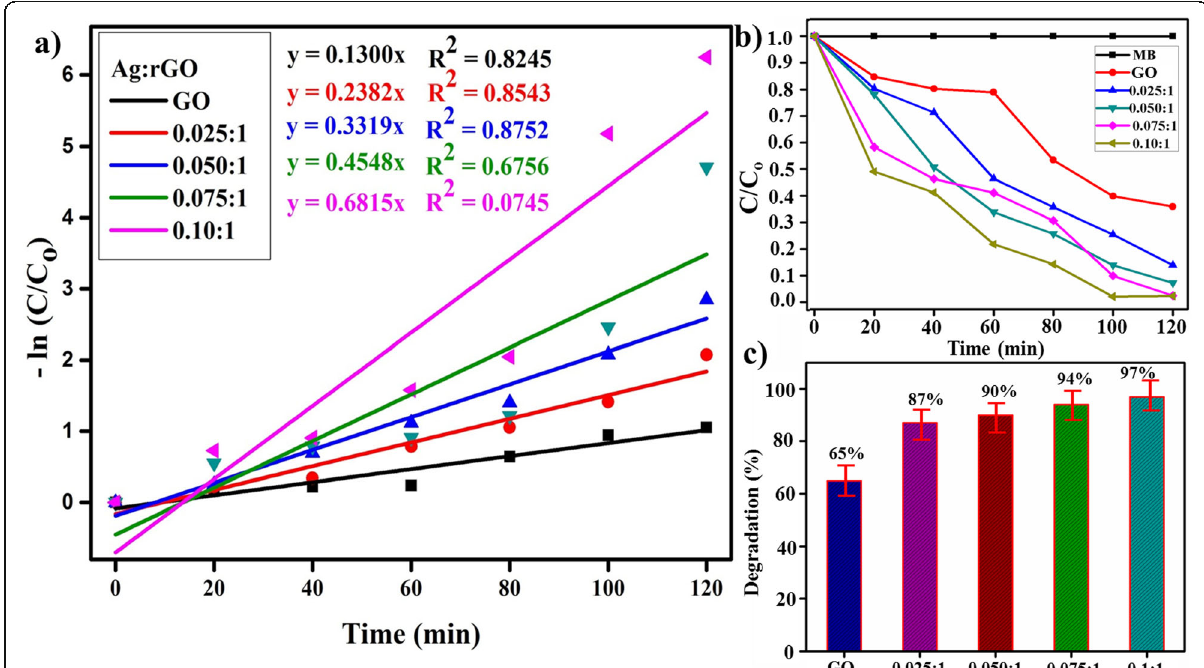
Fig. 9 a Plot of -ln (Ct/C0) versus time spectra for dye reduction. b Plot of concentration ratio (C/C 0 ) versus time. c Degradation (%) comparison of all